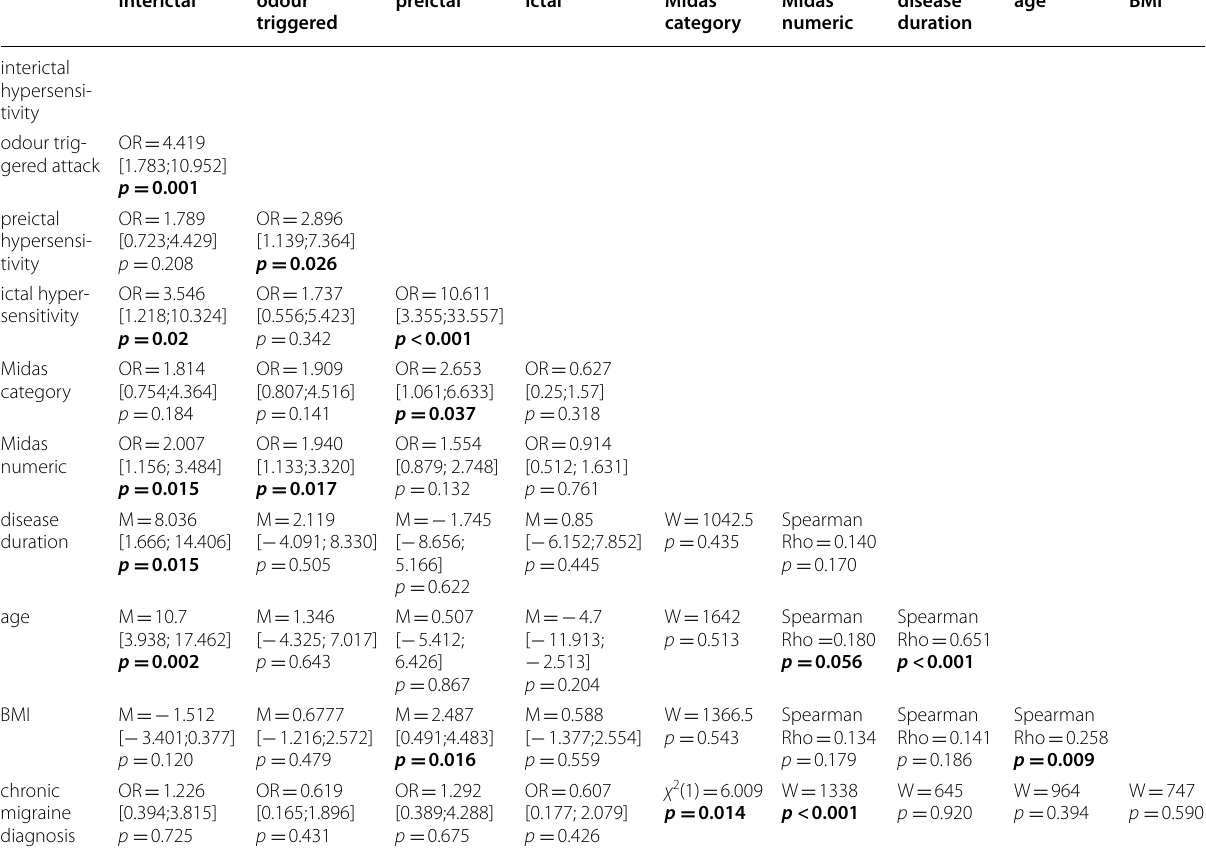
Table 3 Migraine diagnosis and olfactory sensitization in n evaluation in categories: high vs. low impairment - cut-off value for MIDAS 21